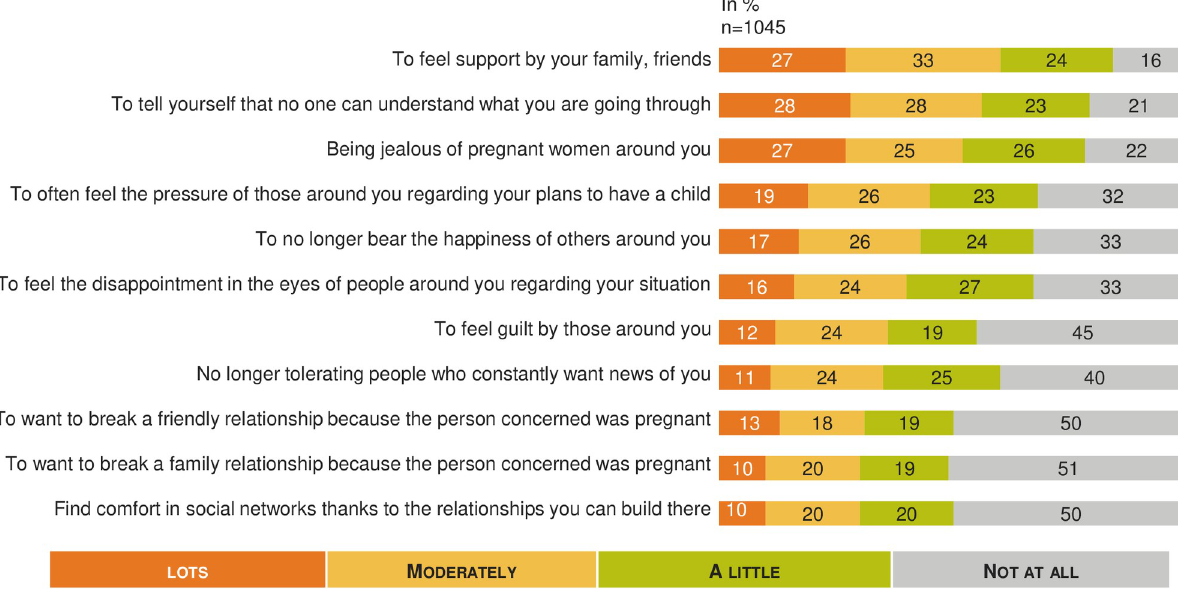
Fig 5. MAR burden on social life: A French national survey. Percentage of answers to the question “Regarding your relationship with those around you, would you say that you felt each of the following a lot, moderately, a little, not at all?” (n = 1 045).